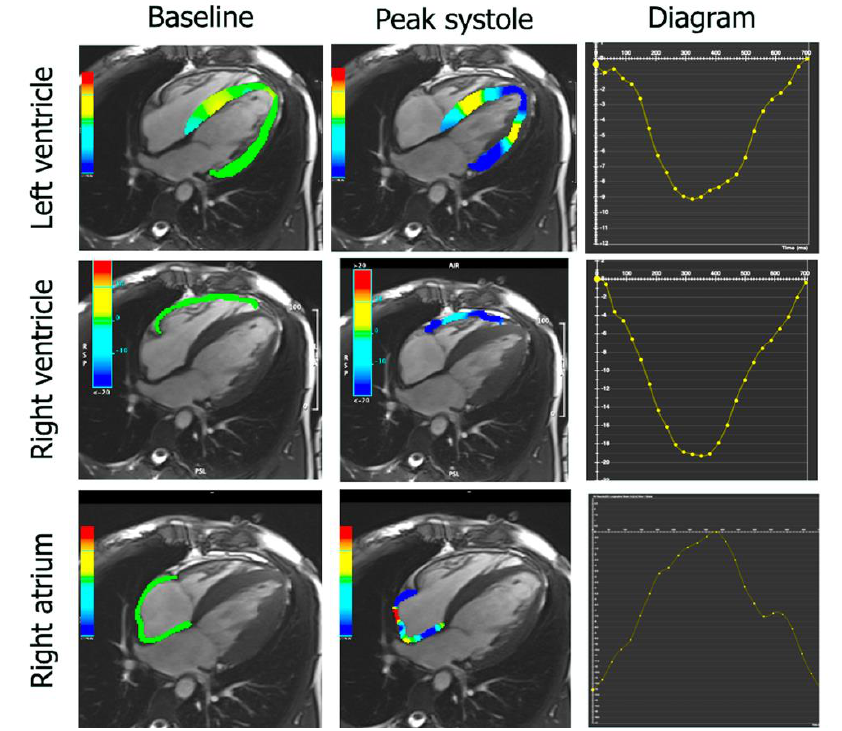
Figure 2. Longitudinal strain analysis in left and right ventricles and in the right atrium. Cardiovas- cular magnetic resonance feature tracking with the use of CVi42 in a patient with peripartum cardi- omyopathy .